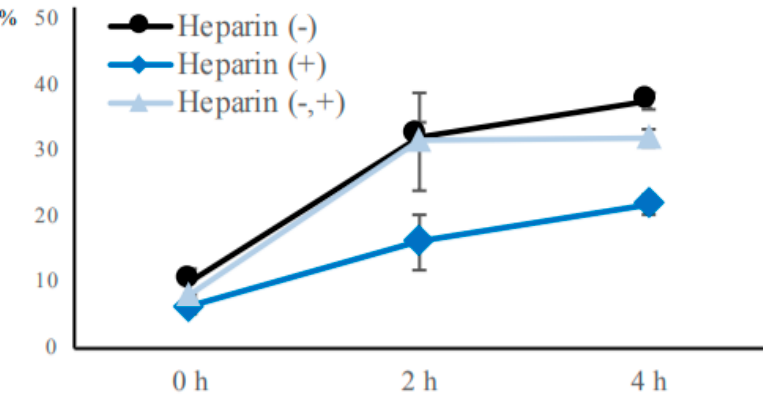
Figure 5. Effect of heparin on the rate of bovine sperm agglutination. The agglutination of sperm incubated without heparin (Heparin ( − ) group), sperm incubated with heparin (Heparin ( + ) group), and sperm incubated without heparin for the first 2 h and with heparin for the subsequent 2 h (Heparin ( − , + ) group) were examined at 0, 2, or 4 h of incubation in non-capacitation medium. The % of agglutination is shown as circles for the Heparin ( − ) group, triangles for the Heparin ( + ) group, and diamonds for the Heparin ( − , + ) group. Data are shown as mean ± SE ( n = 4).